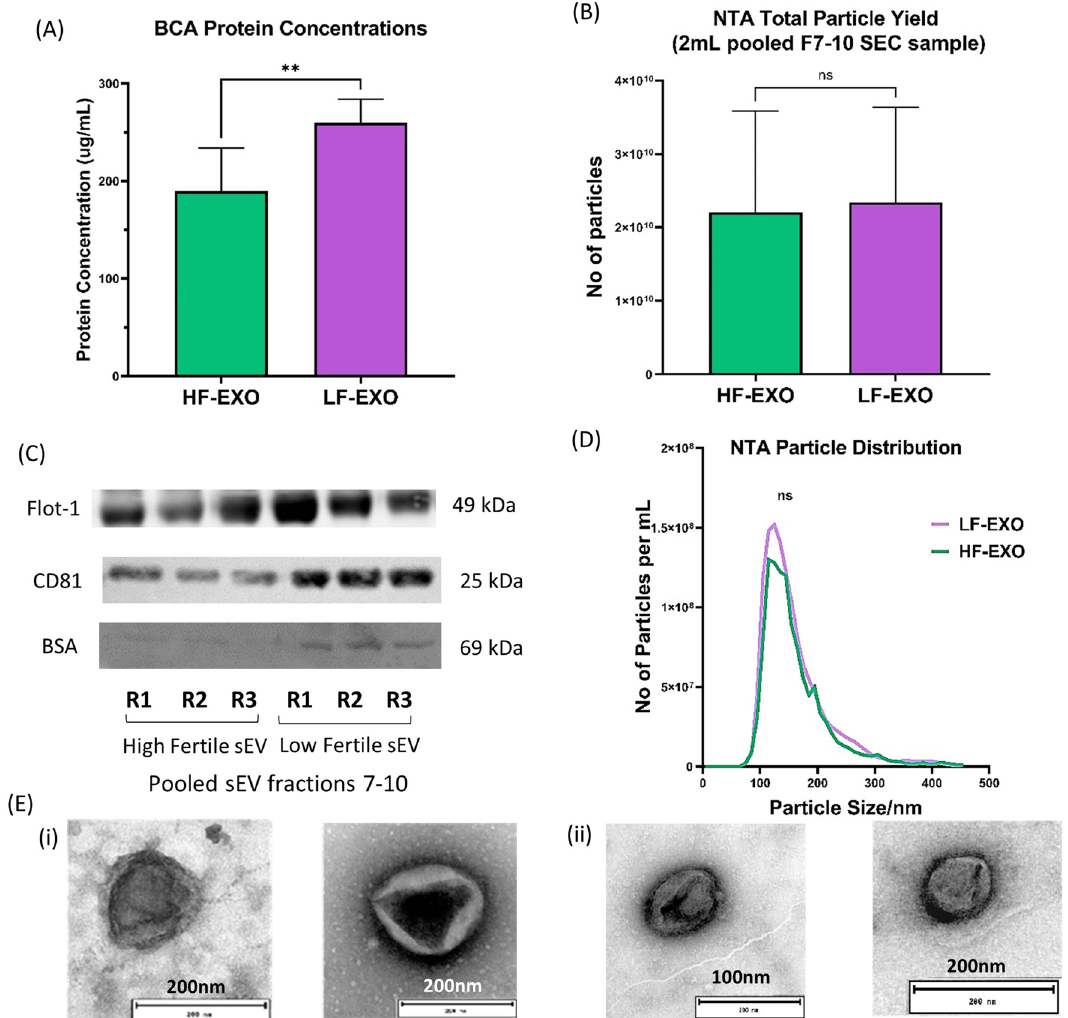
Figure 1. Blood plasma sEV from high fertile and low-fertile both confirmed sEV characteristics and differ in total protein concentrations. ( A ) Total protein content of sEV from low fertile dairy cow plasma are significantly higher than the high fertile. Values are presented as mean ± SD (**P < 0.001; Mann–Whitney test). ( B ) However, there’s no significant difference between the particle number (yield) according to the nano-particle tracking analysis (NTA) results. Values are presented as mean ± SD (**P < 0.001; Mann–Whitney test). ( C ) Representation of western blot sEV/exosome marker CD81, FLOT-1 and negative sEV/exosome marker BSA for pooled sEV fractions 7–10 of HF-EXO and LF-EX. Presence of FLOT-1 and CD81 and less abundance of BSA confirmed sEV/exosome. The full western blot images are available in the Supplementary File 3 ( D ) The size of sEV (nm) is within the defined size (30–200 nm)—average nano-particle tracking analysis (NTA) particle size distribution of HF-EXO and LF-Exo biological replicates (n = 10 each). There was no statistically significant difference between HF-EXO and LF-EXO particle size distributions (ns represents P > 0.05; Mann–Whitney test). ( E ) Spherical shape was confirmed in electron micrographs of exosomes from both (i) HF-EXO and (ii) LF-EXO compared to HF-EXO, however, non-exosome protein marker BSA was prominent in LF-EXO. BSA is the most abundant protein in cow blood plasma 49 , hence considered as a non-exosome protein marker to asses plasma protein contamination in sEV samples (Fig. 1C) 50 . Further sEV characterizations confirm the isolated sEV samples contain spherical cup-shaped particles with size ranges from 30 to 200 nm (Fig. 1D and E) which accepts the definition of exosomes. Nevertheless, presence of exosome protein markers Flot-1, CD81 in contrast to low abundance of BSA in both HF-EXO and LF-EXO ensures the characteristics of sEV. Incubation of blood plasma HF-EXO and LF-EXO on bovine endometrial stromal (bCSC) cells leads to changes in inflammatory related genes. To investigate the effect of blood plasma sEV on the endometrial tissue, bovine endometrial stromal (bCSC) cells (Fig. 2A) were exposed to HF-EXO and LF-EXO, and then, inflammatory mediator gene expressions were assessed using real-time quantitative PCR (Fig. 2B–I).